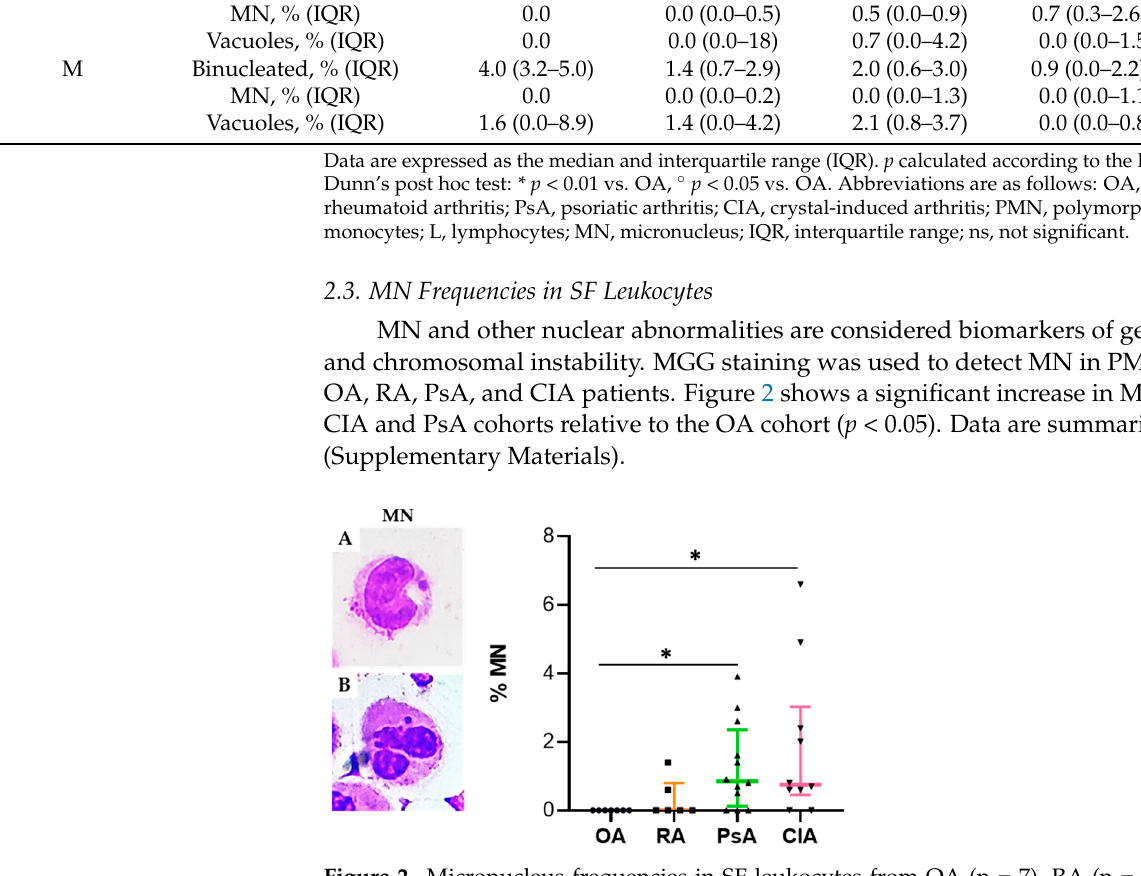
Figure 2. Micronucleus frequencies in SF leukocytes from OA (n = 7), RA (n = 6), PsA (n = 12), and CIA (n = 10). Left panel: representative image of monocytes with MN ( A ) and PMN with MN ( B ) stained with MGG. Right panel: rate of MN in SFs leukocytes. Data are shown as the median (IQR).